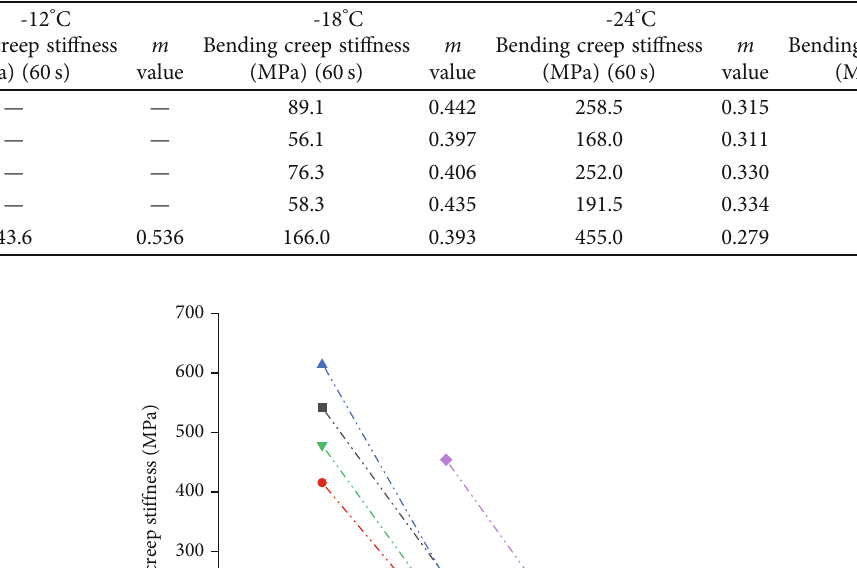
Table 5: Flexural creep test results of tire rubber powder-modi fi ed asphalt.